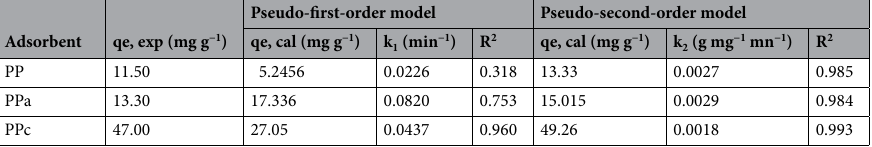
Pseudo-first-order